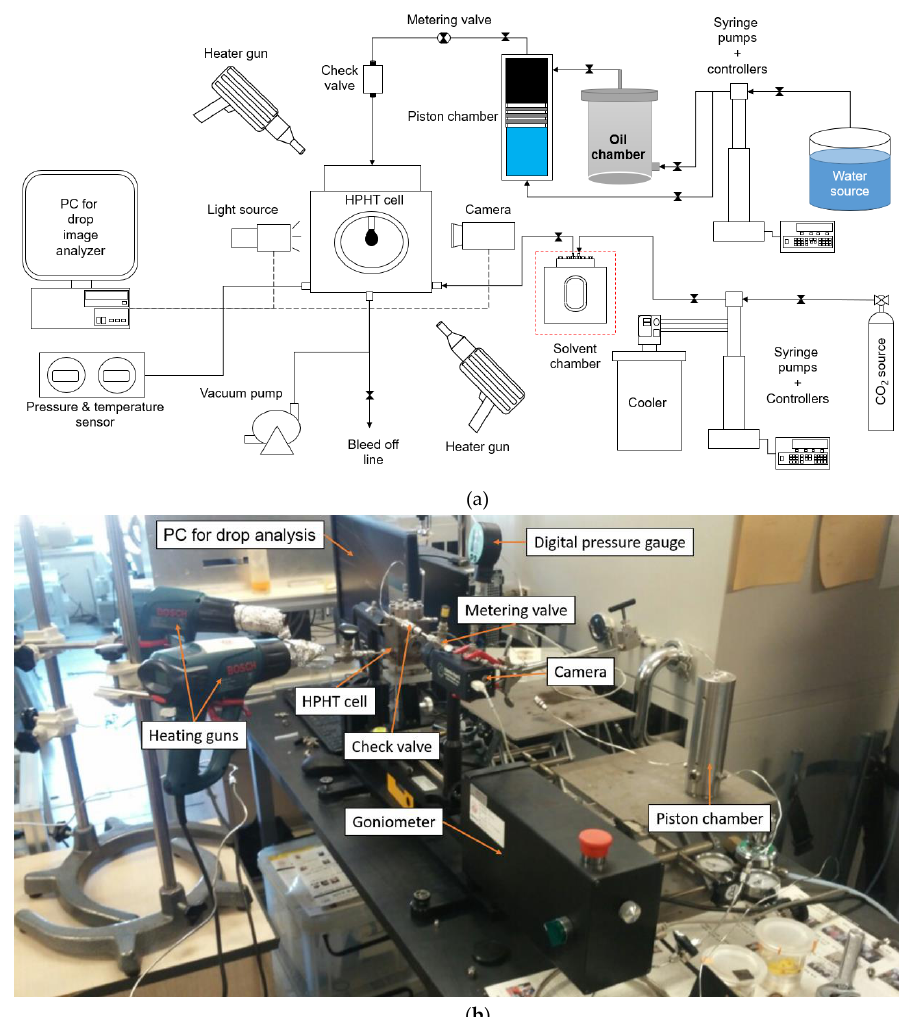
Figure 2. Vanishing interfacial tension (VIT) test apparatus measuring the interfacial tension (IFT): (a) a schematic diagram of the VIT test system and (b) a photograph of the actual experiment equipment.